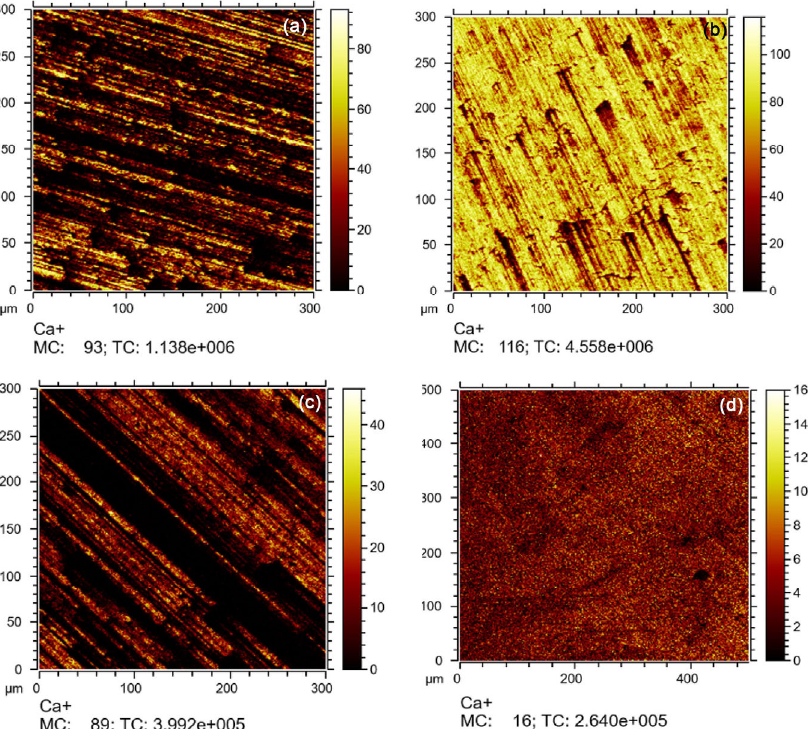
Fig. 8 ToF-SIMS mappings (300 μ m × 300 μ m) of Ca for post-test (24 h endurance) steel surfaces: (a) ATF-A, (b) ATF-B, (c) ATF-C, and (d)